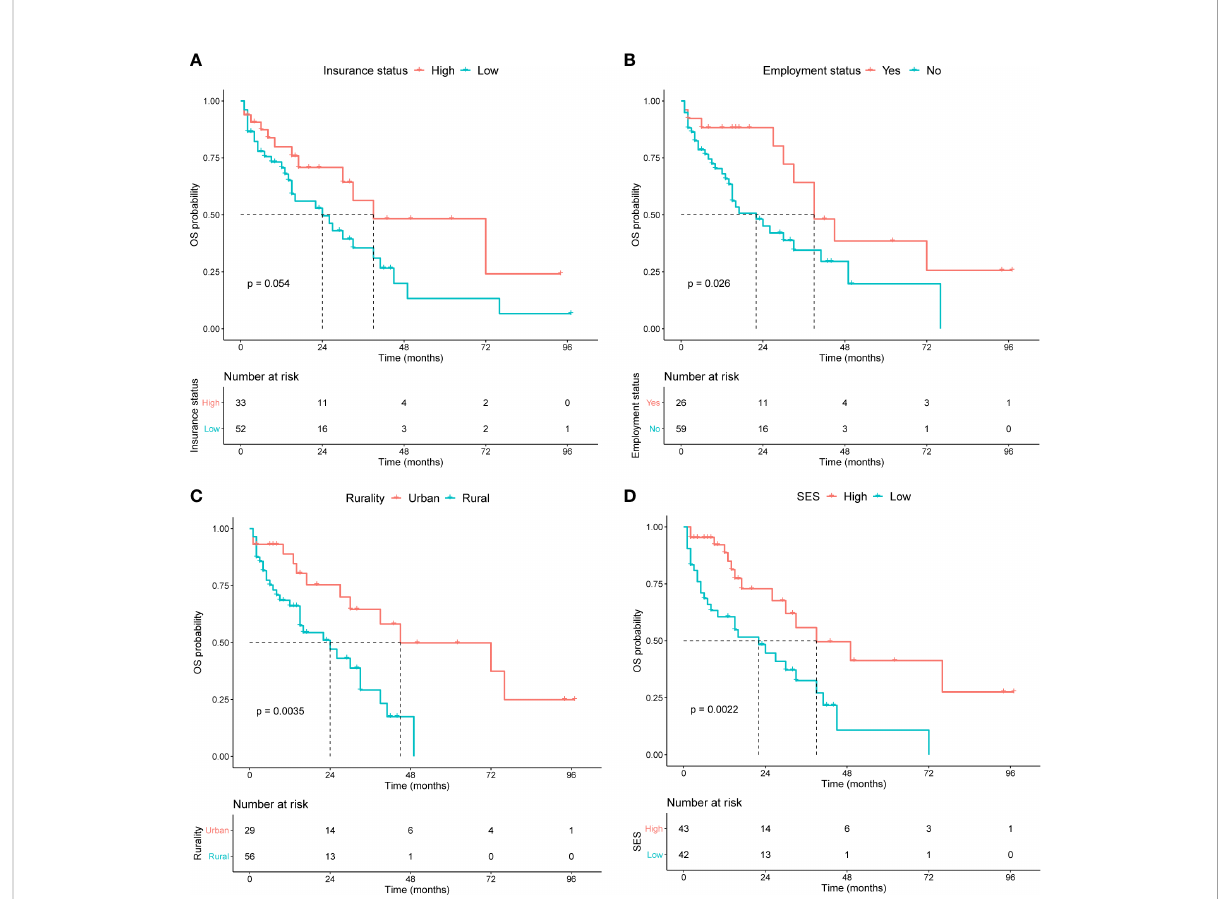
FIGURE 3 Kaplan-Meier survival curves in the training cohort for OS strati fi ed by (A) insurance status, (B) employment status, (C) rurality, and (D)